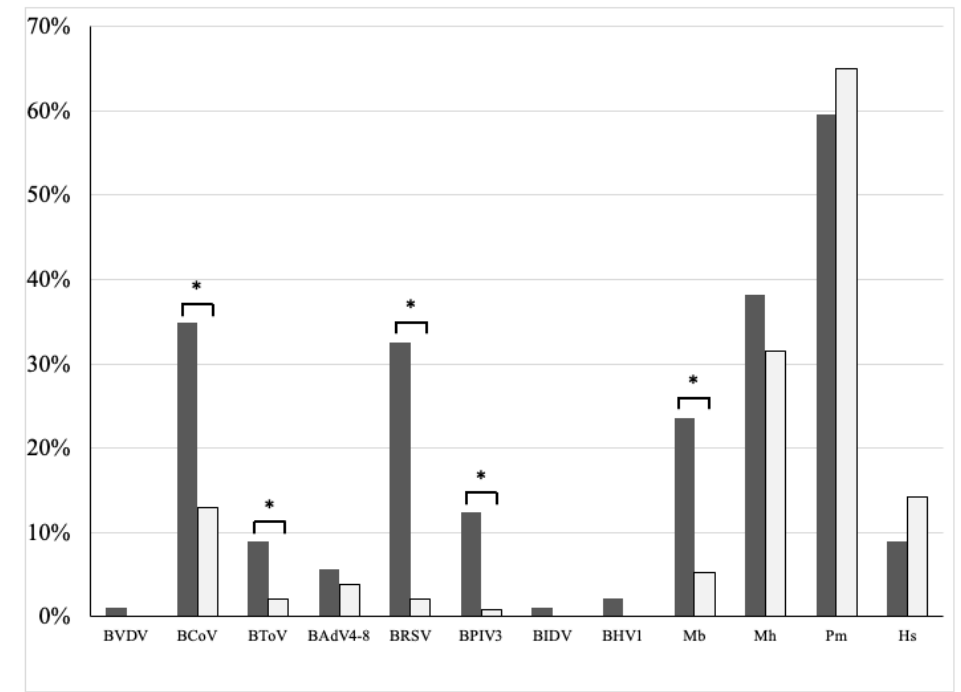
Figure 2. Comparison of PCR-specific gene detection rates for 12 pathogens by multiplex real-time RT-PCR between 89 nasal swabs from 89 calves with respiratory disease and 232 nasal swabs from 63 clinically healthy calves collected in Iwate prefecture during 2019 to 2021. The black bars indicate the PCR-specific gene detection rate for 12 pathogens from calves with respiratory symptoms, and white bars indicate the PCR-specific gene detection rate for 12 pathogens from clinically healthy calves. The asterisk (*) means significant differences ( p < 0.05) between two groups by statistical analysis using Fisher’s exact test.